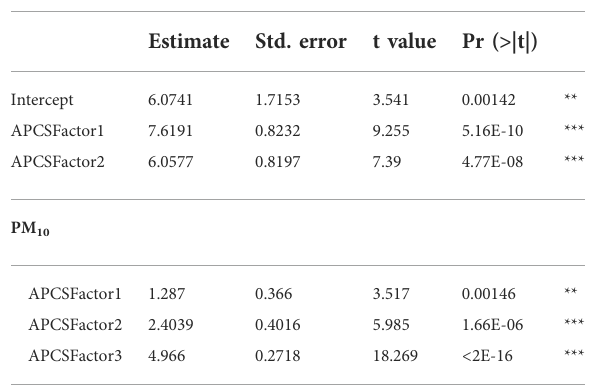
and re-suspension (Al, Mg, Si, and S), Factor 2 — Break wear (Cu, Fe), Factor 3 — Exhaust emissions and tire wear (K, Zn, and PM 2.5 )